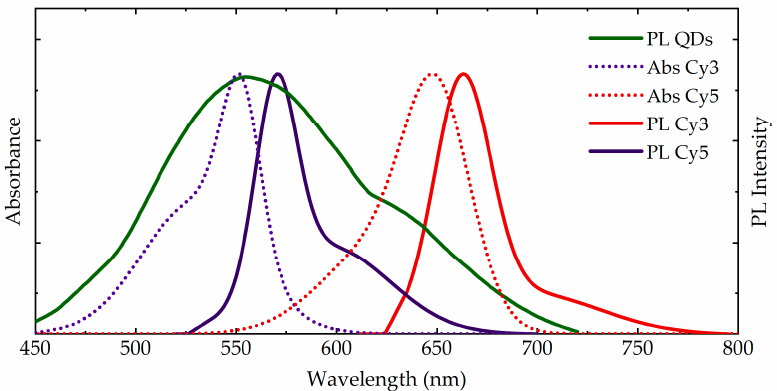
Figure 1. Absorption (dotted lines) and PL (solid lines) spectra of aqueous solutions of AgInS 2 /ZnS quantum dots (QDs) (green) and the cyanine dyes: Cy3 (purple) and Cy5 (red). PL excitation wavelengths: QDs—405 nm, Cy3—500 nm, Cy5—600 nm.